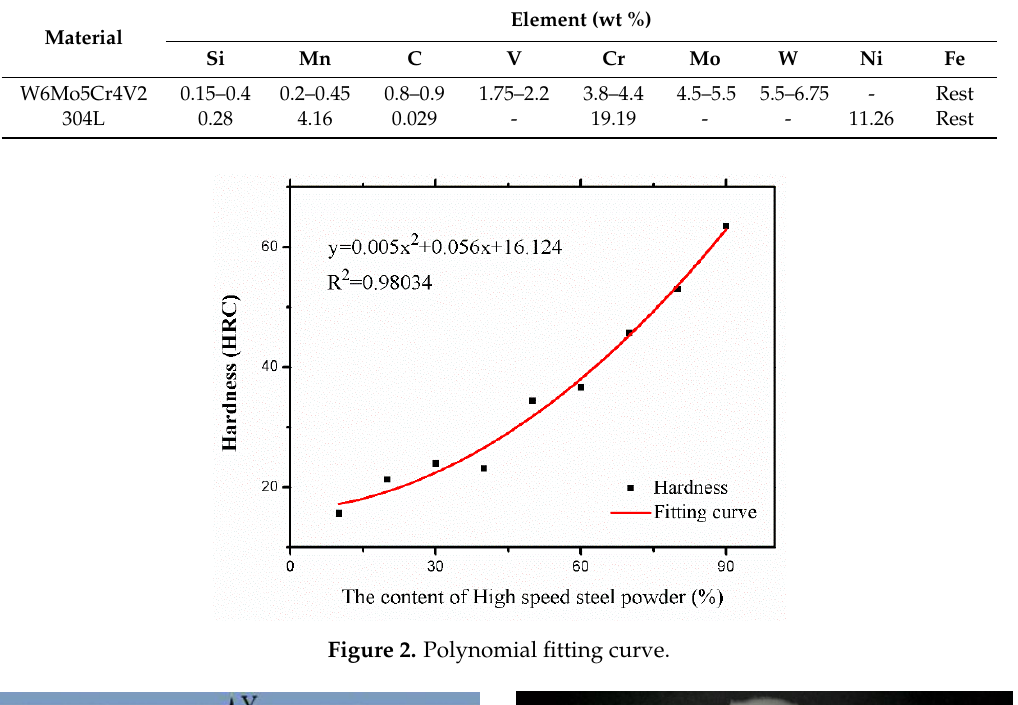
Figure 1 ． ( a ) Morphology of high speed steel powder; ( b ) Morphology of 304 stainless steel powder. Table 1. Powder elements composition (wt %) of high speed steel (W6Mo5Cr4V2) and 304 stainless steel (304L).